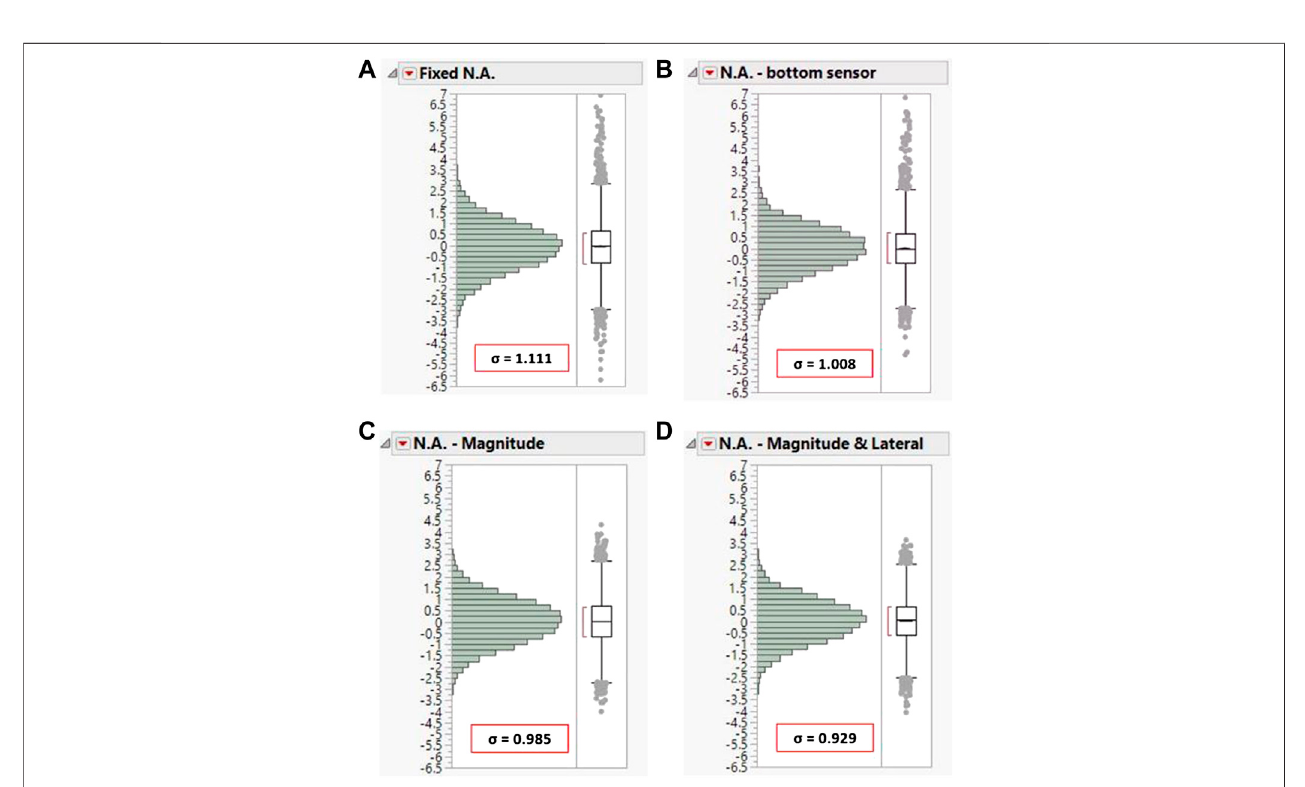
FIGURE 9 | Distribution of residuals from the four different models: (A) fi xed N.A., (B) N.A. estimated based on bottom sensor measurement, (C) N.A. estimated based on magnitude of the applied load, and (D) N.A. estimated based on magnitude and lateral position of applied load.